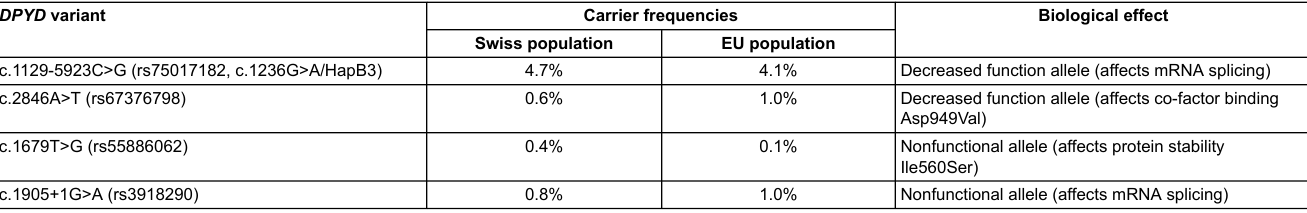
Table 2: DPYD risk variants. DPYD